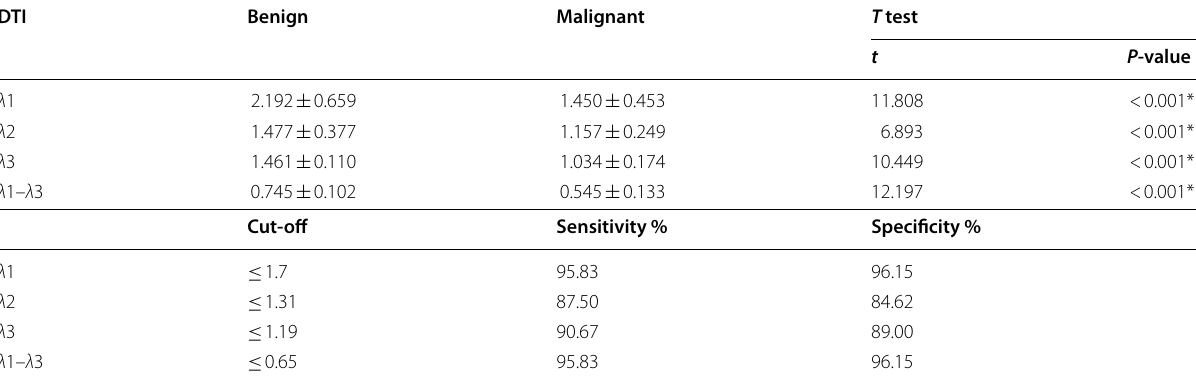
Data are presented as mean SD, *: significant difference at p value < 0.05, DTI: diffusion tensor imaging. λ 1, λ 2, λ 3: maximum, middle and minimum eigenvalues, ± respectively. λ 1– λ 3: maximum anisotropy index